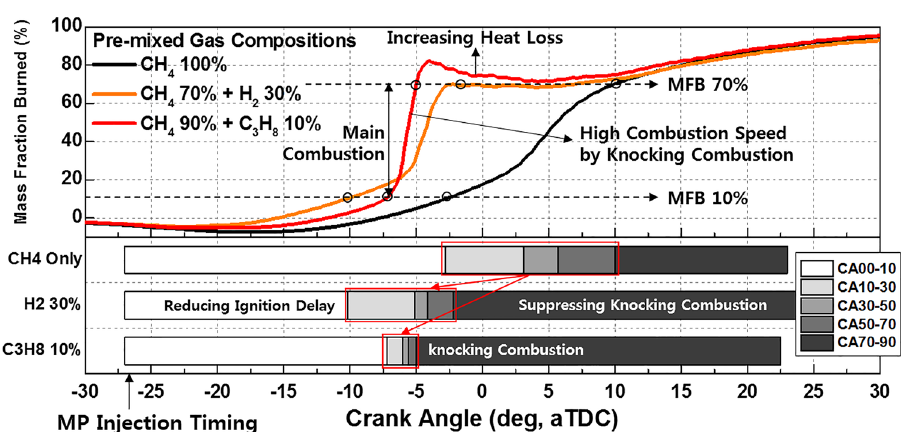
Figure 15. Variation in the MFB with the C 3 H 8 and H 2 gas mixture